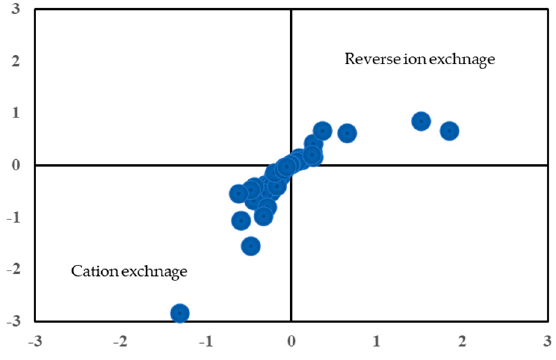
Figure 12. Ion exchange diagram of groundwater samples in the study region.